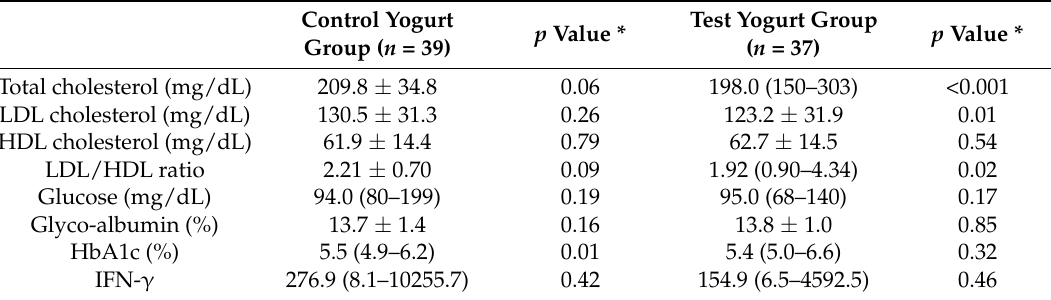
Table 2. Effect of yogurt on serum parameters.